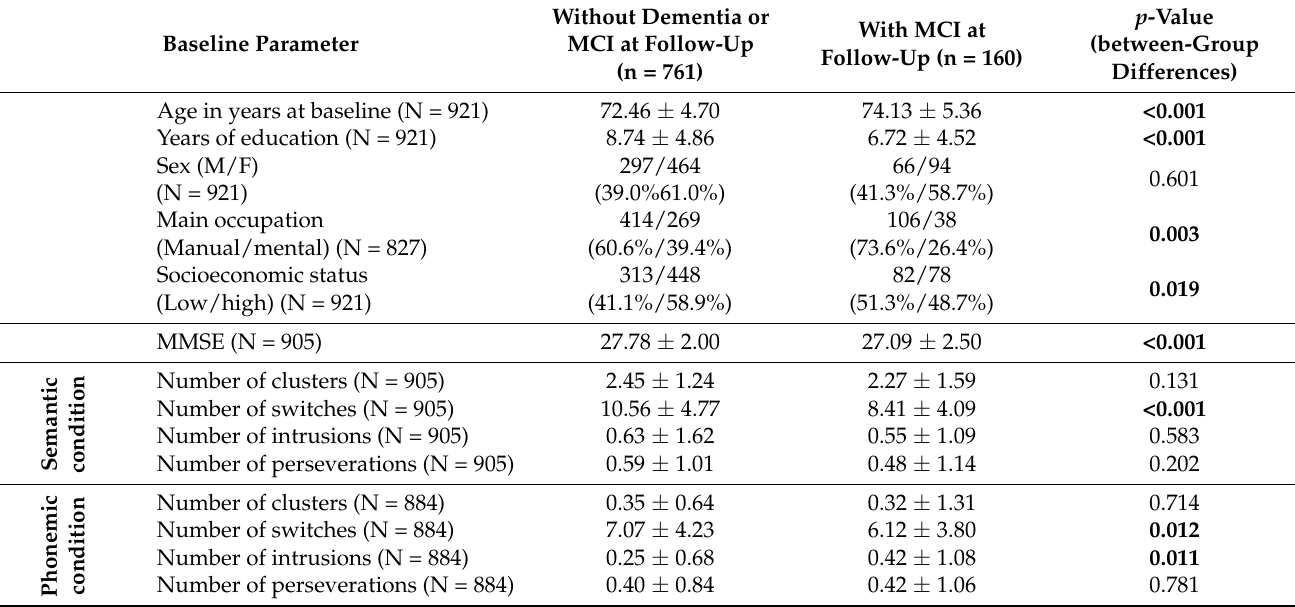
Table 2. Baseline characteristics of cognitively normal participants based on the diagnosis of mild cognitive impairment (MCI) or not at follow-up.